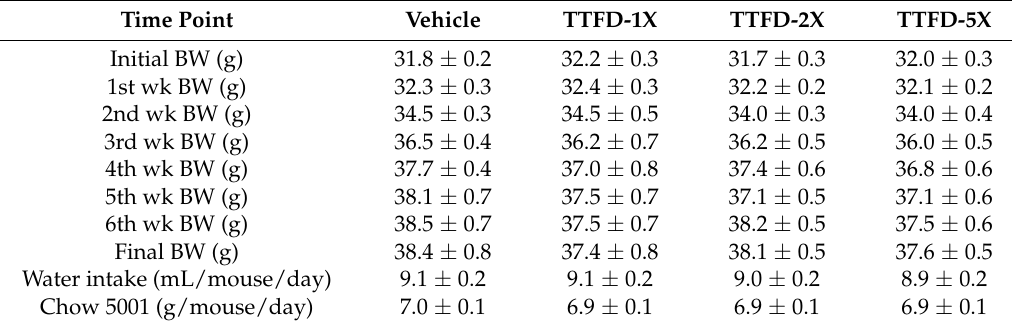
Table 2. Growth curve and dietary profiles during experiments.